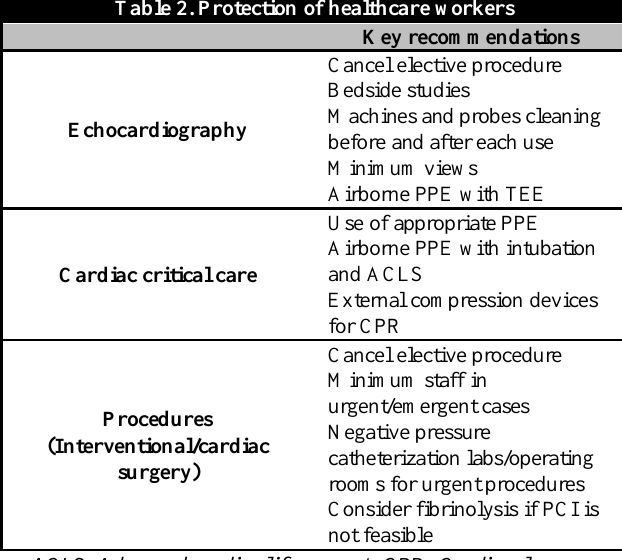
Table 2. Protection of healthcare